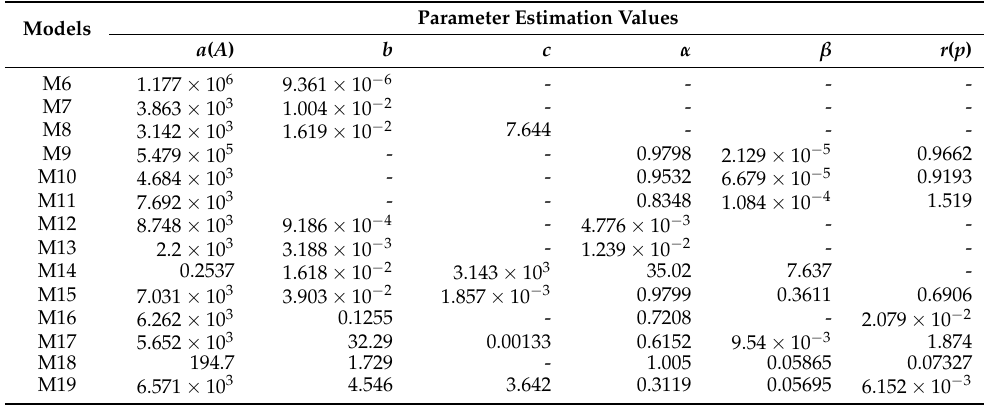
Table 6. Parameter estimates of M6 to M19 for DS-3.